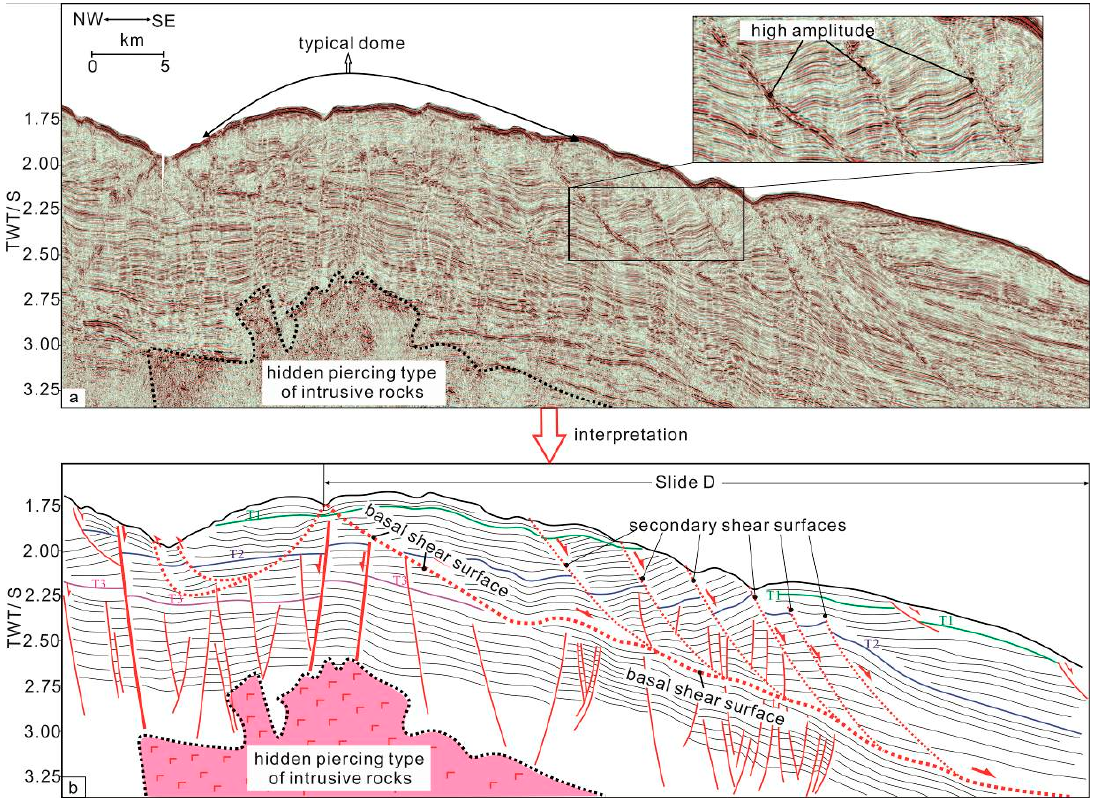
Figure 4. Seismic reflection profile of Line 3 is a landslide induced by hidden piercing intrusive rocks and interpretation of genetic model.